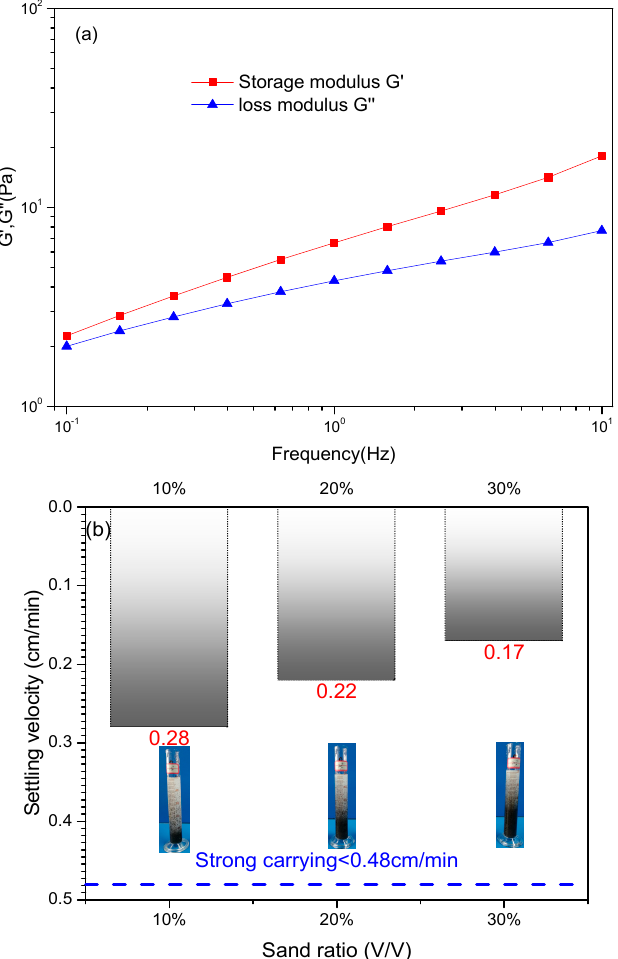
Figure 9. Performance as fracturing fluids at room temperature: ( a ) Storage modulus G’ and loss modulus G” of, and ( b ) settling velocity of the ceramsites in the 0.6 wt% PAANM solution with 150 ppm of PEI and 1000 ppm of carbohydrazide.